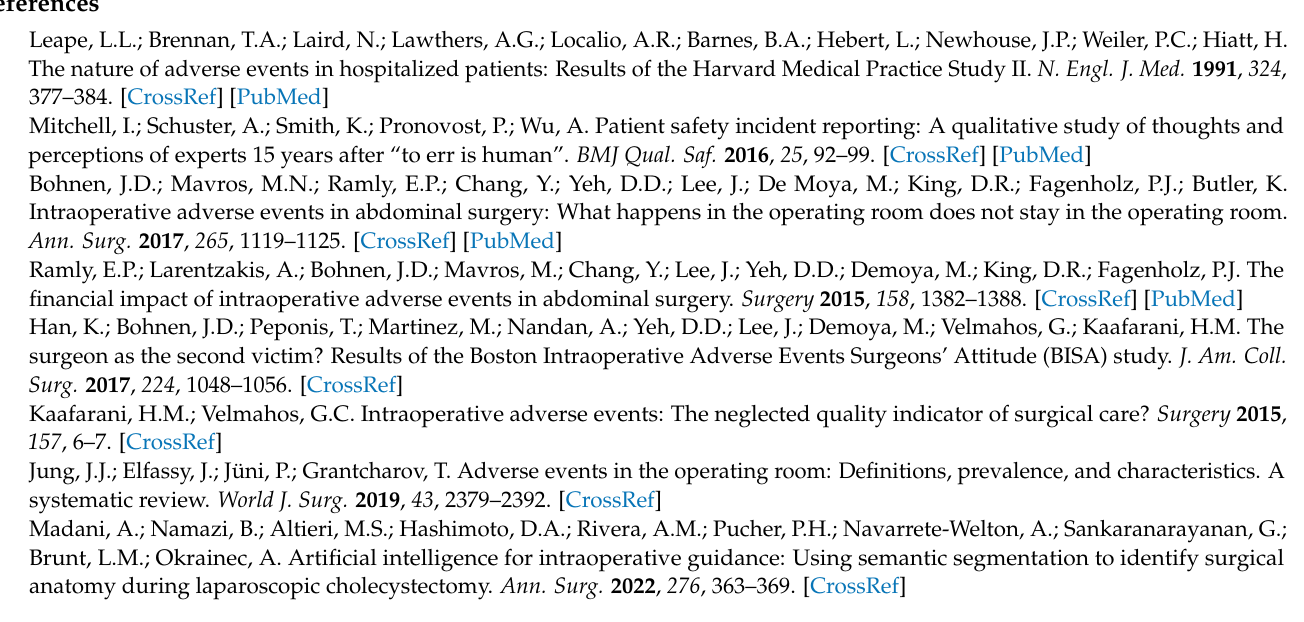
by Database; Table S2: Study Outcomes; Figures S1 and S2: Forest Plots of sensitivity; Figure S3: Flow-charts of Methodologies for Automatically Detecting Adverse